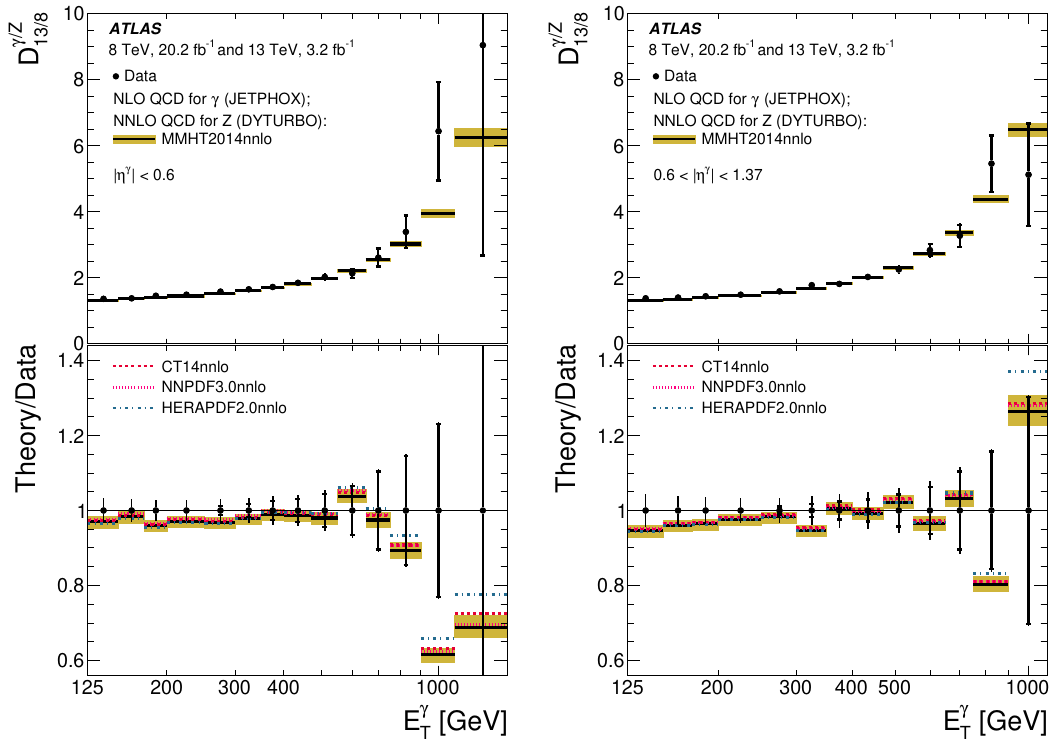
Figure 8 . The measured D (cid:13)=Z (dots) as a function of E (cid:13) in di(cid:11)erent regions of j (cid:17) (cid:13) j . The pQCD T 13 = 8 predictions based on the MMHT2014nnlo PDFs (black lines) are also shown. The inner (outer) error bars represent the statistical (total) uncertainties. The shaded band represents the theoretical uncertainty in the predictions. For most of the points, the error bars are smaller than the marker size and, thus, not visible. The lower part of the (cid:12)gures shows the ratio of the pQCD predictions based on the MMHT2014nnlo PDFs to the measured D (cid:13)=Z (black lines). The ratios of the pQCD 13 = 8 predictions based on di(cid:11)erent PDF sets to the measured D (cid:13)=Z are also included. 13 = 8